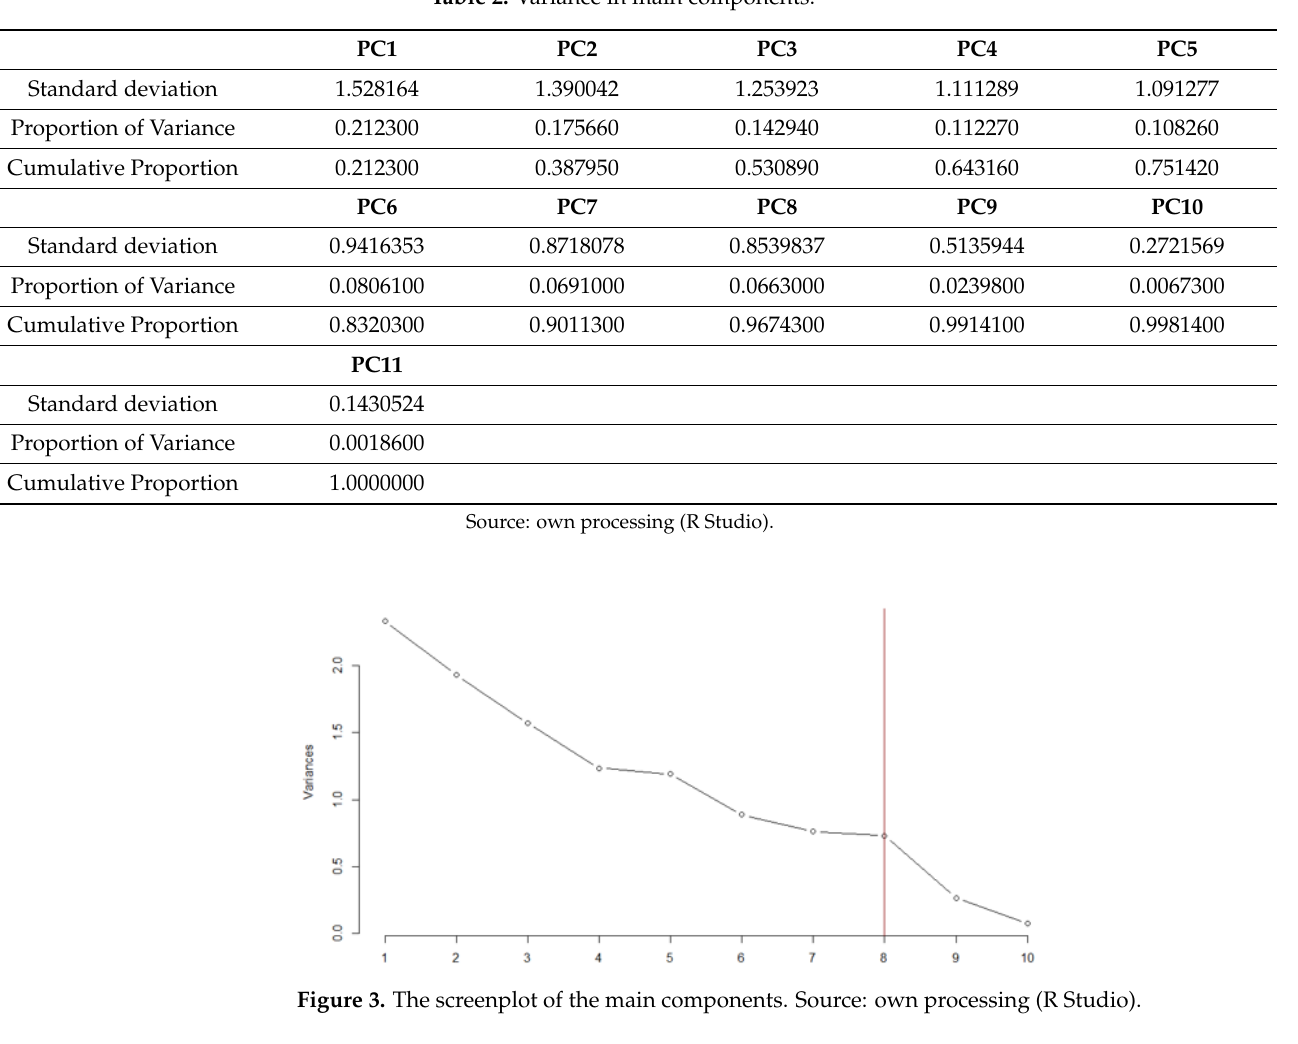
Table 2. Variance in main components.